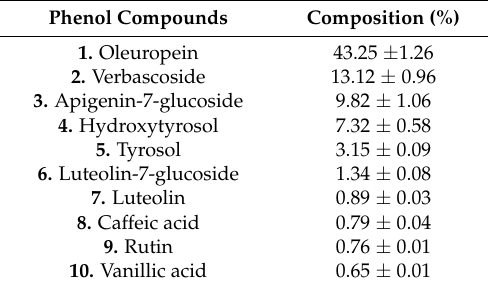
Mean ± SD (standard deviation) of three determinations by the HPLC-DAD